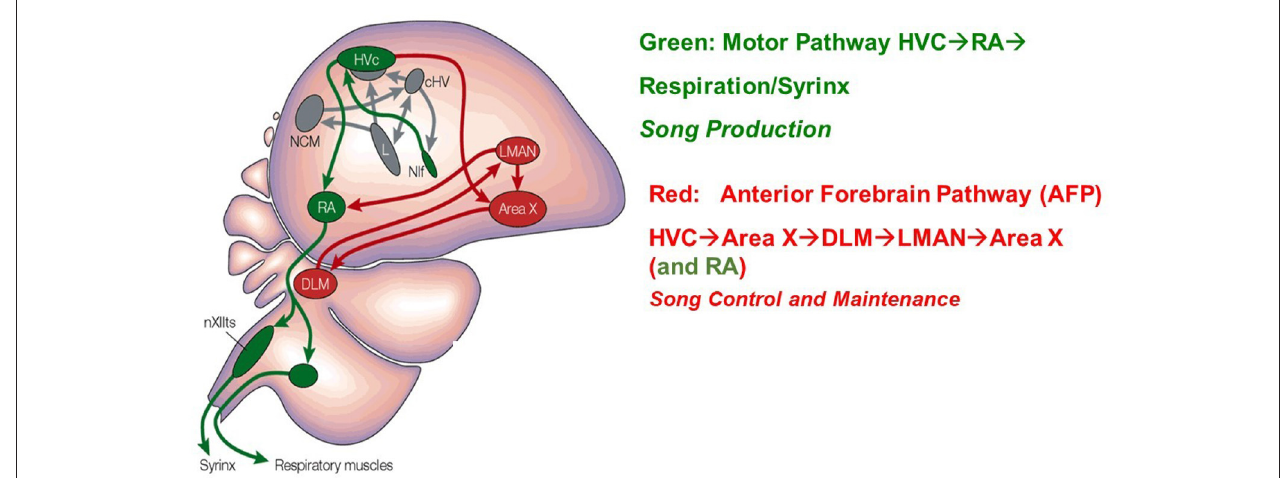
FIGURE 2 | A drawing of the Song Production Pathway and the Anterior Forebrain Pathway of avian songbirds. Parts of the auditory pathways are shown in gray. Pathways from the brainstem that ultimately return to HVC are not shown. The HVC network image is taken from Brainard and Doupe [ 33]. Reprinted by permission from Copyright Clearance Center: Springer